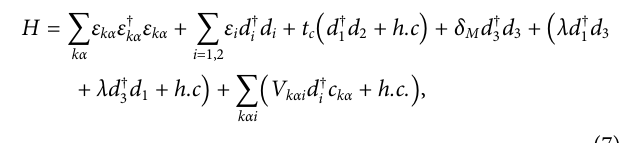
For q (cid:1) 0 (serially connected double QDs), the conductance shows two Lorentz peaks at the bonding and antibonding states, respectively. Whereas for 0 < q < 1, the resonance at the antibonding state ε (cid:1) t c shows the typical asymmetrical Fano line-shape, which has been systematically investigated in Refs. 28